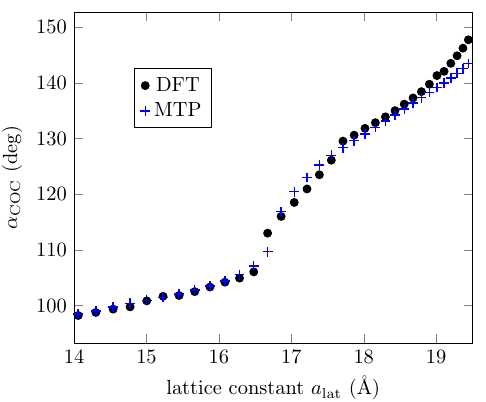
Figure 4. DFT-optimized structures compared to MTP predictions: C-O-C